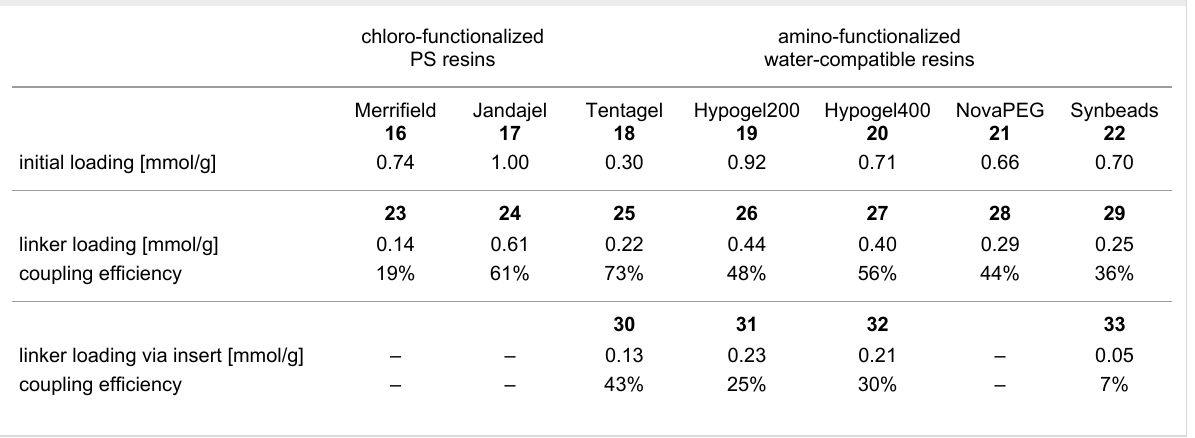
Table 1: Functionalization of different resins with linker 1 and loading